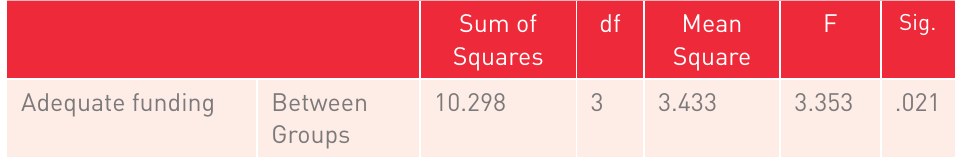
Analysis of Variance (ANOVA) between different functions of the respondents within organizations Sum